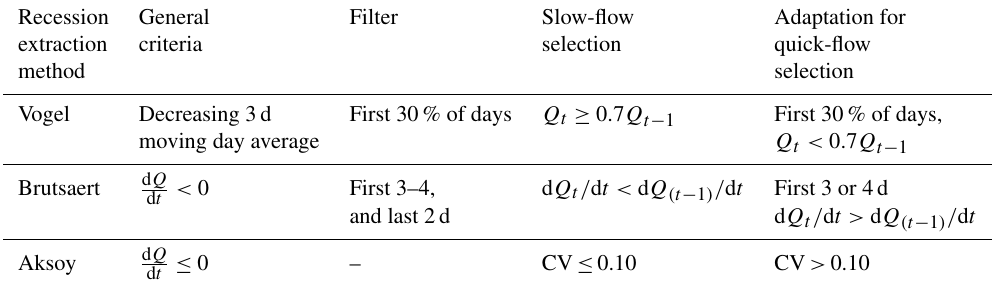
Table 1. Criteria for recession extraction methods